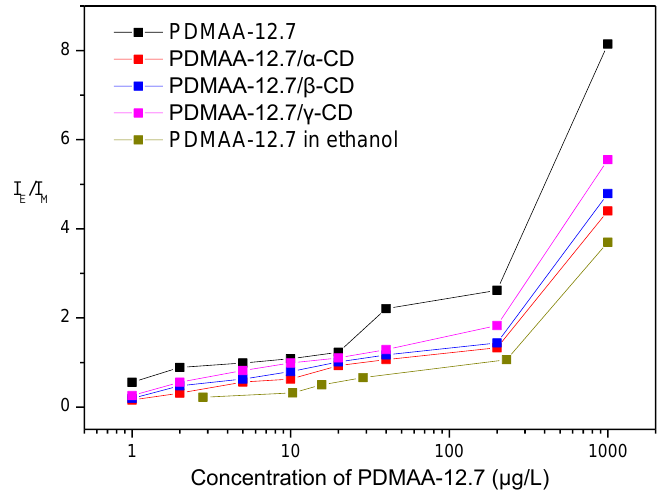
Figure 6. The ratio of excimer to monomer emission intensities (I E / I M ) as a function of the concentration of PDMAA-12.7 copolymers in ethanol and in water with equivalent α -CD, β -CD and γ -CD, respectively.